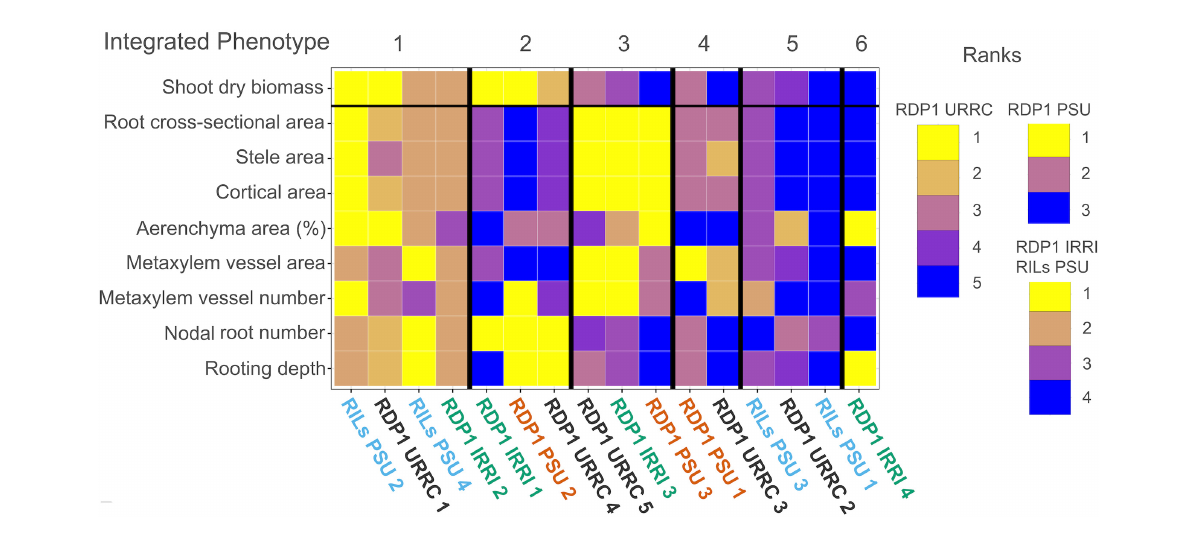
FIGURE4 Heatmap of drought cluster phenotype rankings and integrated phenotypes. Summary heatmap of drought phenotype rankings among experiments. Median trait values of each cluster were ranked greatest (yellow) to least (blue) compared to the other cluster trait medians within each experiment. Each column represents phenotype ranks from one cluster. Clusters with similar trait rankings across experiments were grouped by integrated